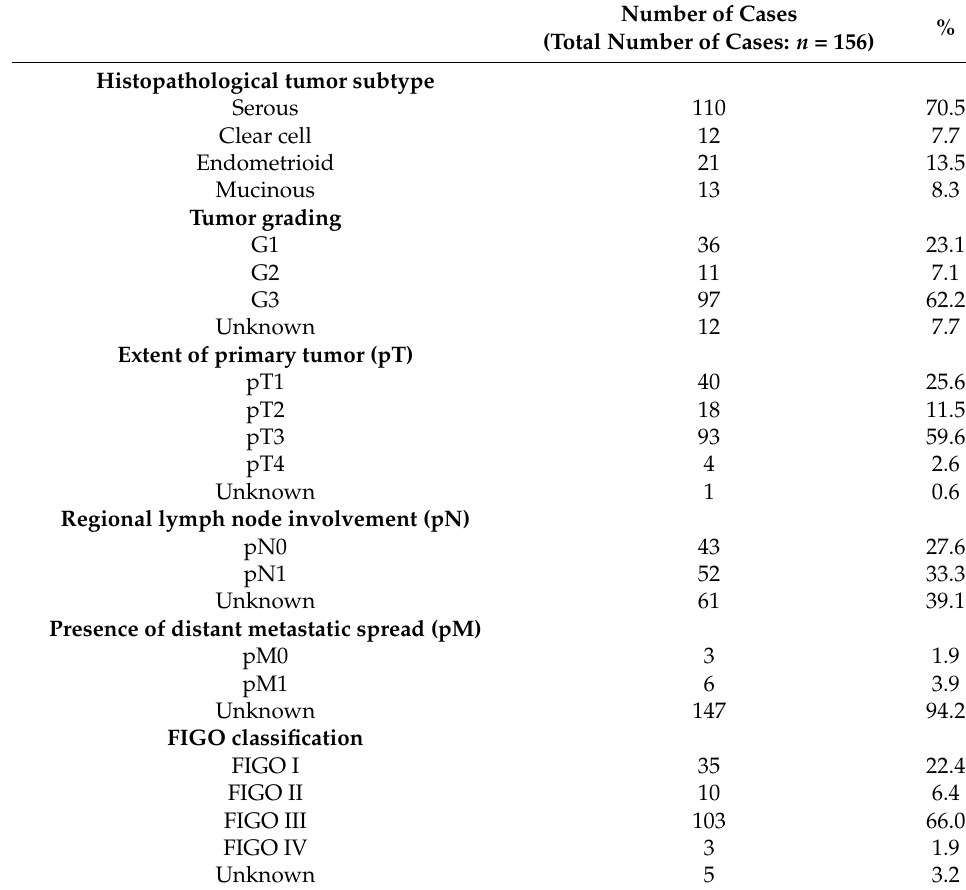
Table 2. Patients’